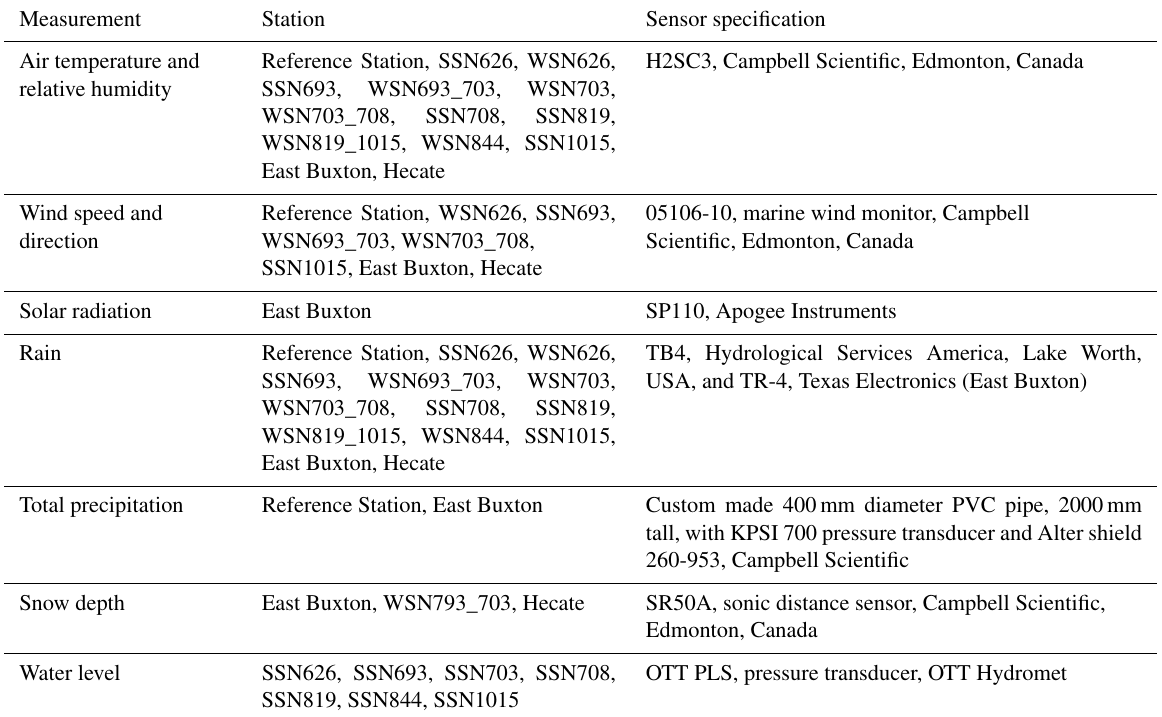
Table A2. Sensor inventory and specifications.